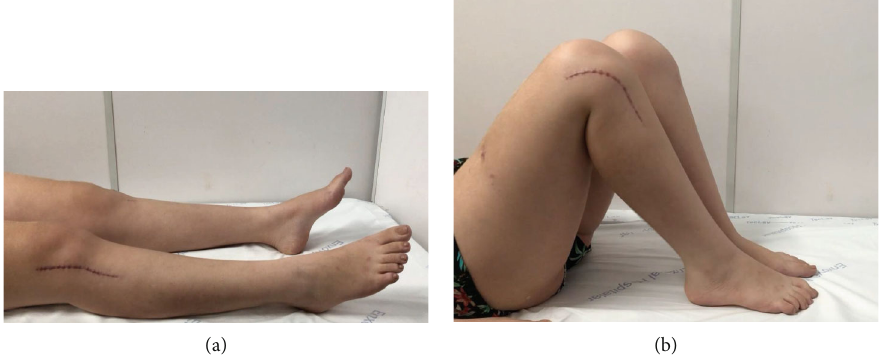
Figure 4: (a, b) Supine photograph showing full range of motion of hips, knees, and